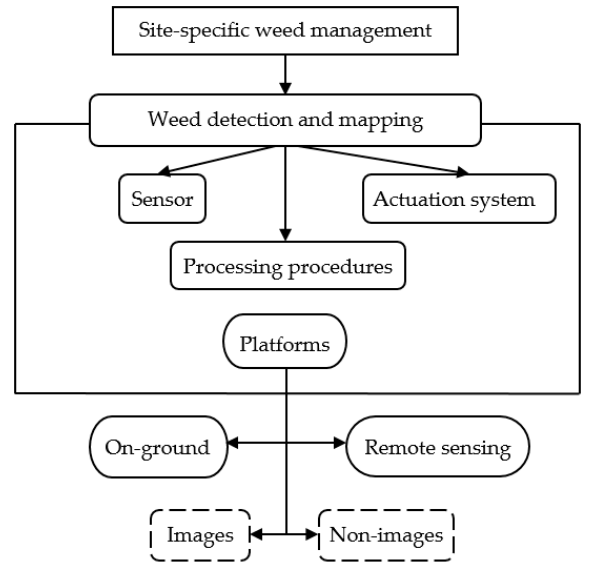
Figure 1. The first step in implementing a site-specific waste management strategy.